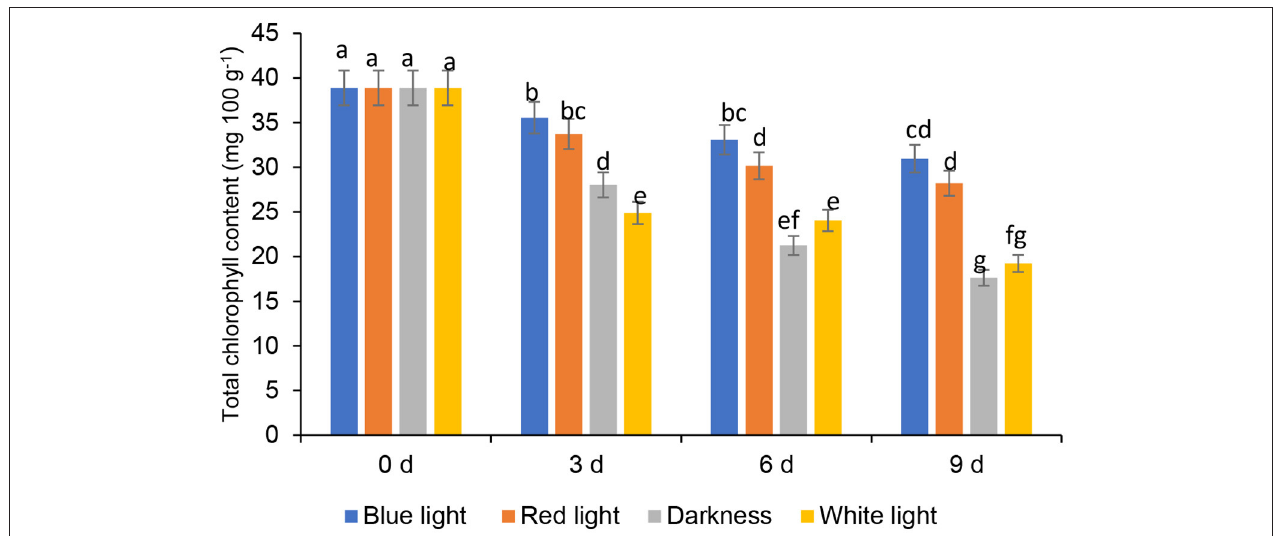
FIGURE 3 | Effect of blue and red LED light treatment on total chlorophyll content in coriander ( Coriandrum sativum ) leaves after post-harvest storage. Bars with the same alphabetic letter along the column are not significantly different at p ≤